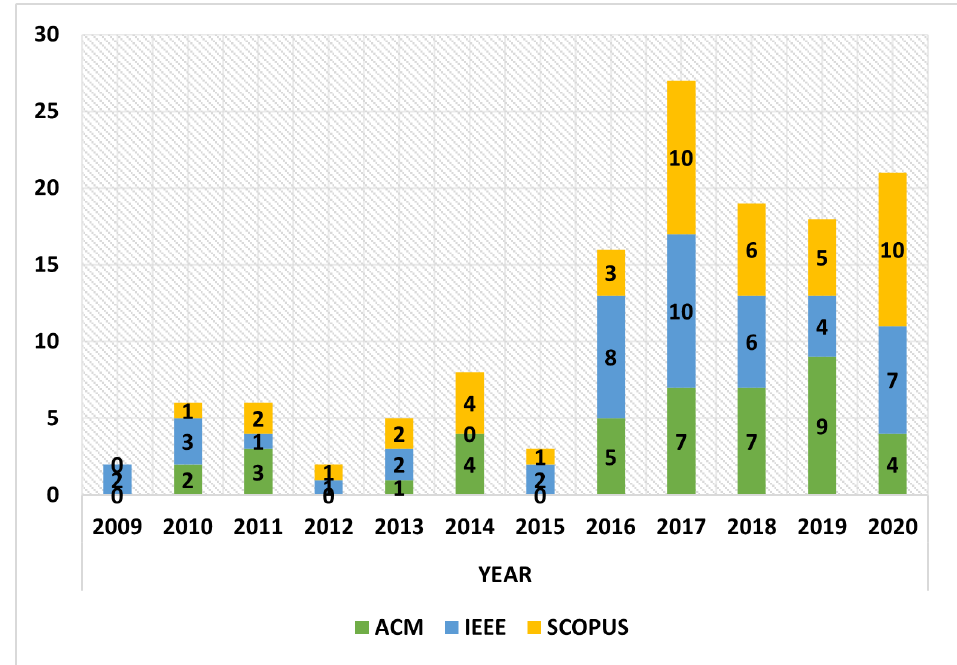
Figure 3. Total number of articles published per year that mention AH.